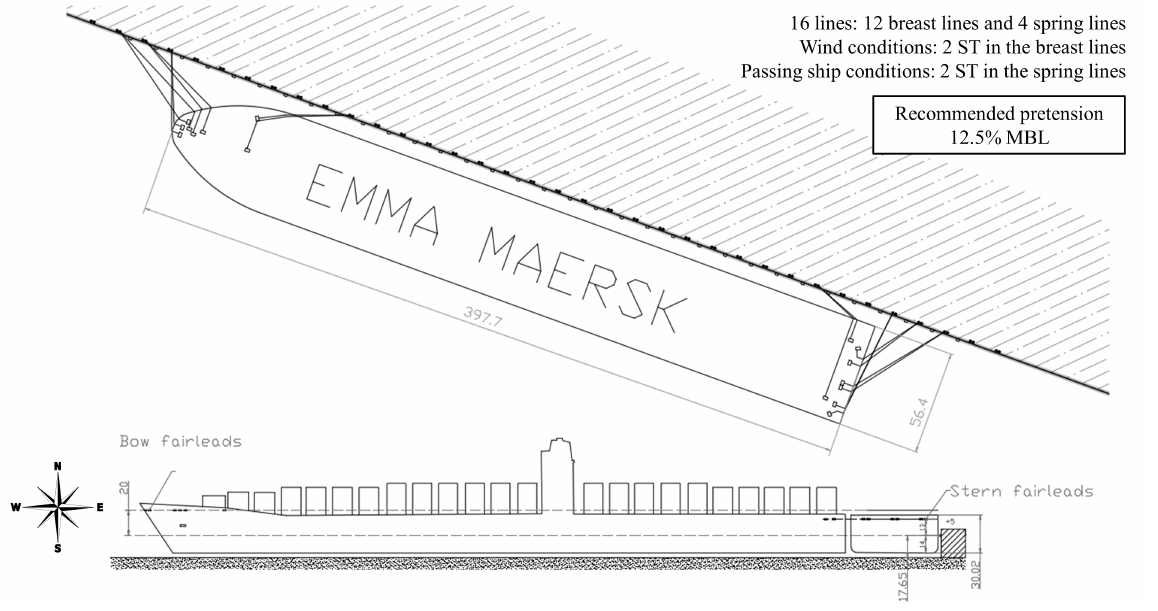
Figure 3. Emma Maersk selected mooring arrangement. Dimensions in